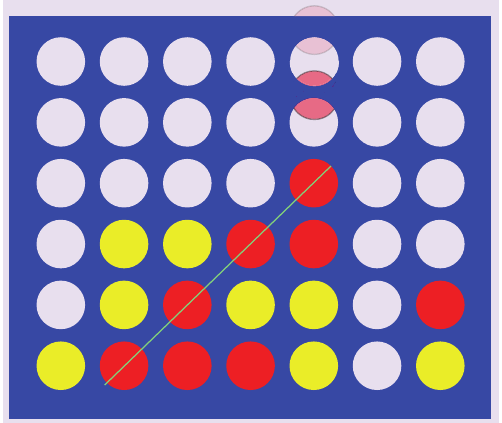
Figure 1: Traditional “Connect Four”. Here, Red wins with four coins aligned diagonally (transparency has been added here to highlight the last command and winning